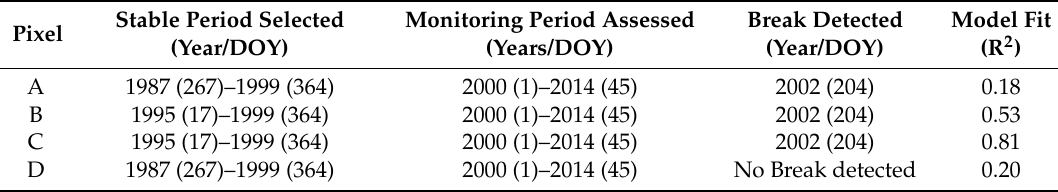
Table 7. Example of Breakpoint detection using BFAST.